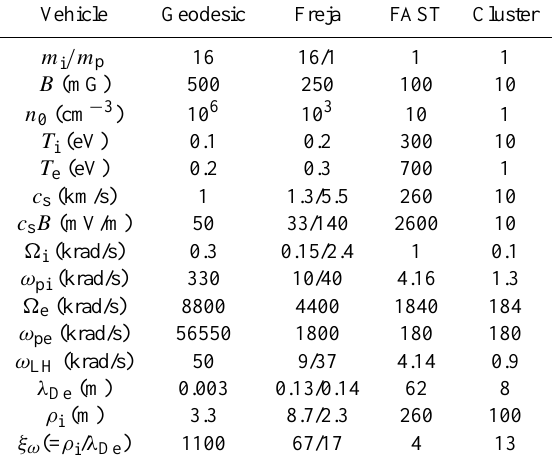
Table 1. Some important space projects and relevant orders of typ- ical plasma parameters measured in the ionospheric auroral F-layer by the Geodesic rocket (Burchill et al., 2004), in the topside iono- sphere by the Freja satellite (Eriksson et al., 1994), in the auroral zone by the FAST satellite (Ergun, 1999), and in the magnetopause by the Cluster satellites (Tjulin et al., 2004). See Sect. 2 for defini- tions of